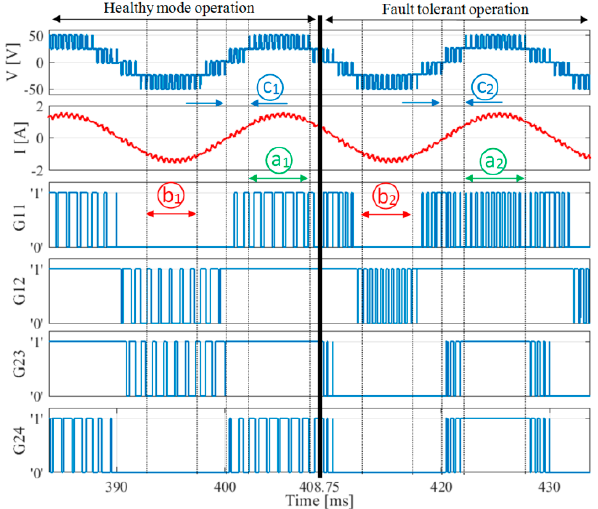
Figure 5. Detailed representation of the fault-tolerant operation in case of open-circuit fault occur- rence in D C4 .